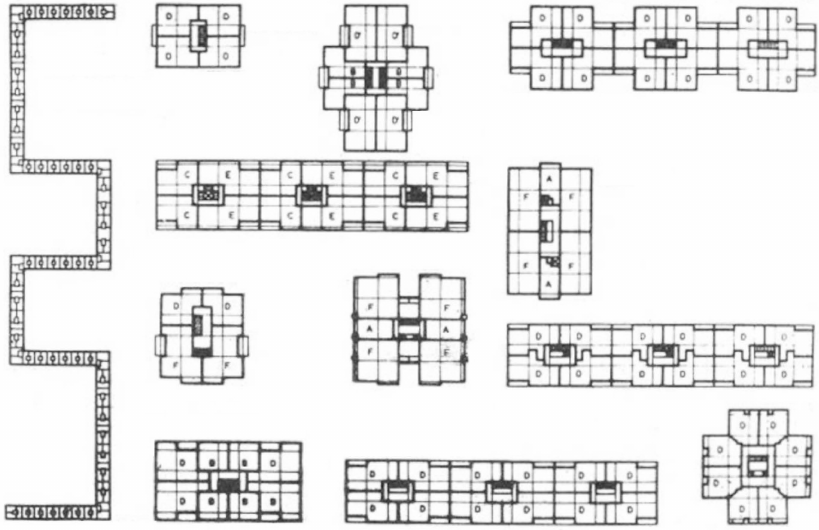
Figure 1. Shames for different housing layouts in IMS technology: Modular range 420/420 cm